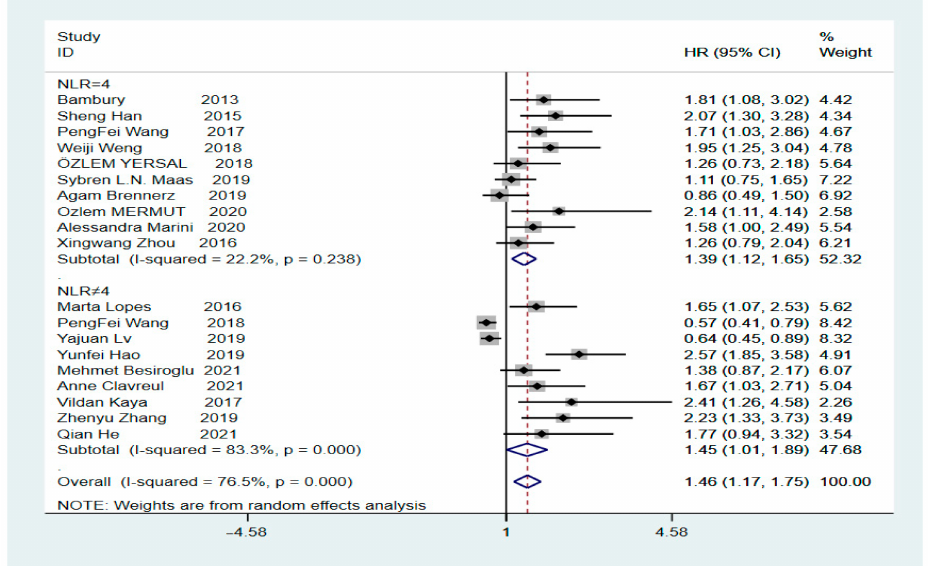
Figure 3. Inclusion of subgroups with a literature cut-off value of 4 and subgroups without a cut-off value of 4 in the analysis.